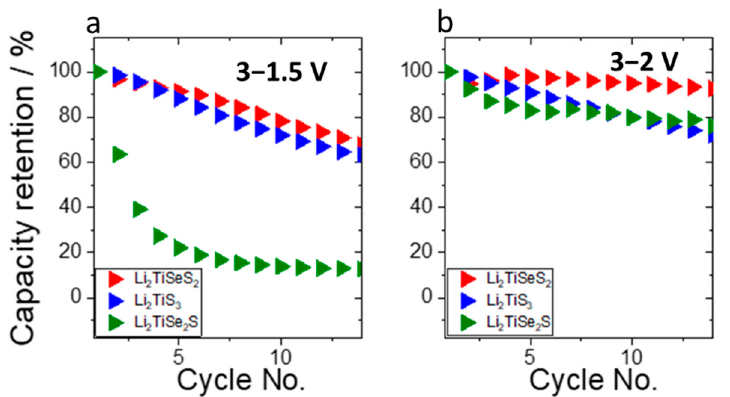
Figure 6. Capacity retention (%) of Li 2 TiS 3 , Li 2 TiSeS 2 , and Li 2 TiSe 2 S cells cycled at a rate of C/10 in different cycling windows: ( a ) 3–1.5 V and ( b ) 3–2.0 V vs. Li + /Li.